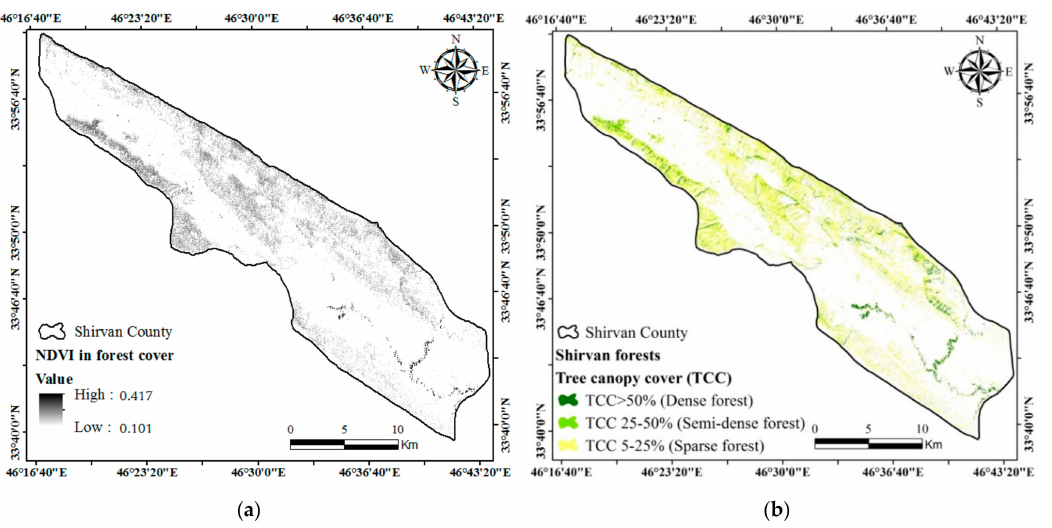
Figure 12. NDVI and TCC% maps in the forest area of Shirvan County. ( a ) NDVI map of forest cover. ( b ) Tree canopy cover map in the forest area. Table 11. Forest density and tree canopy cover in the forest area of Shirvan County based on the predictive regression